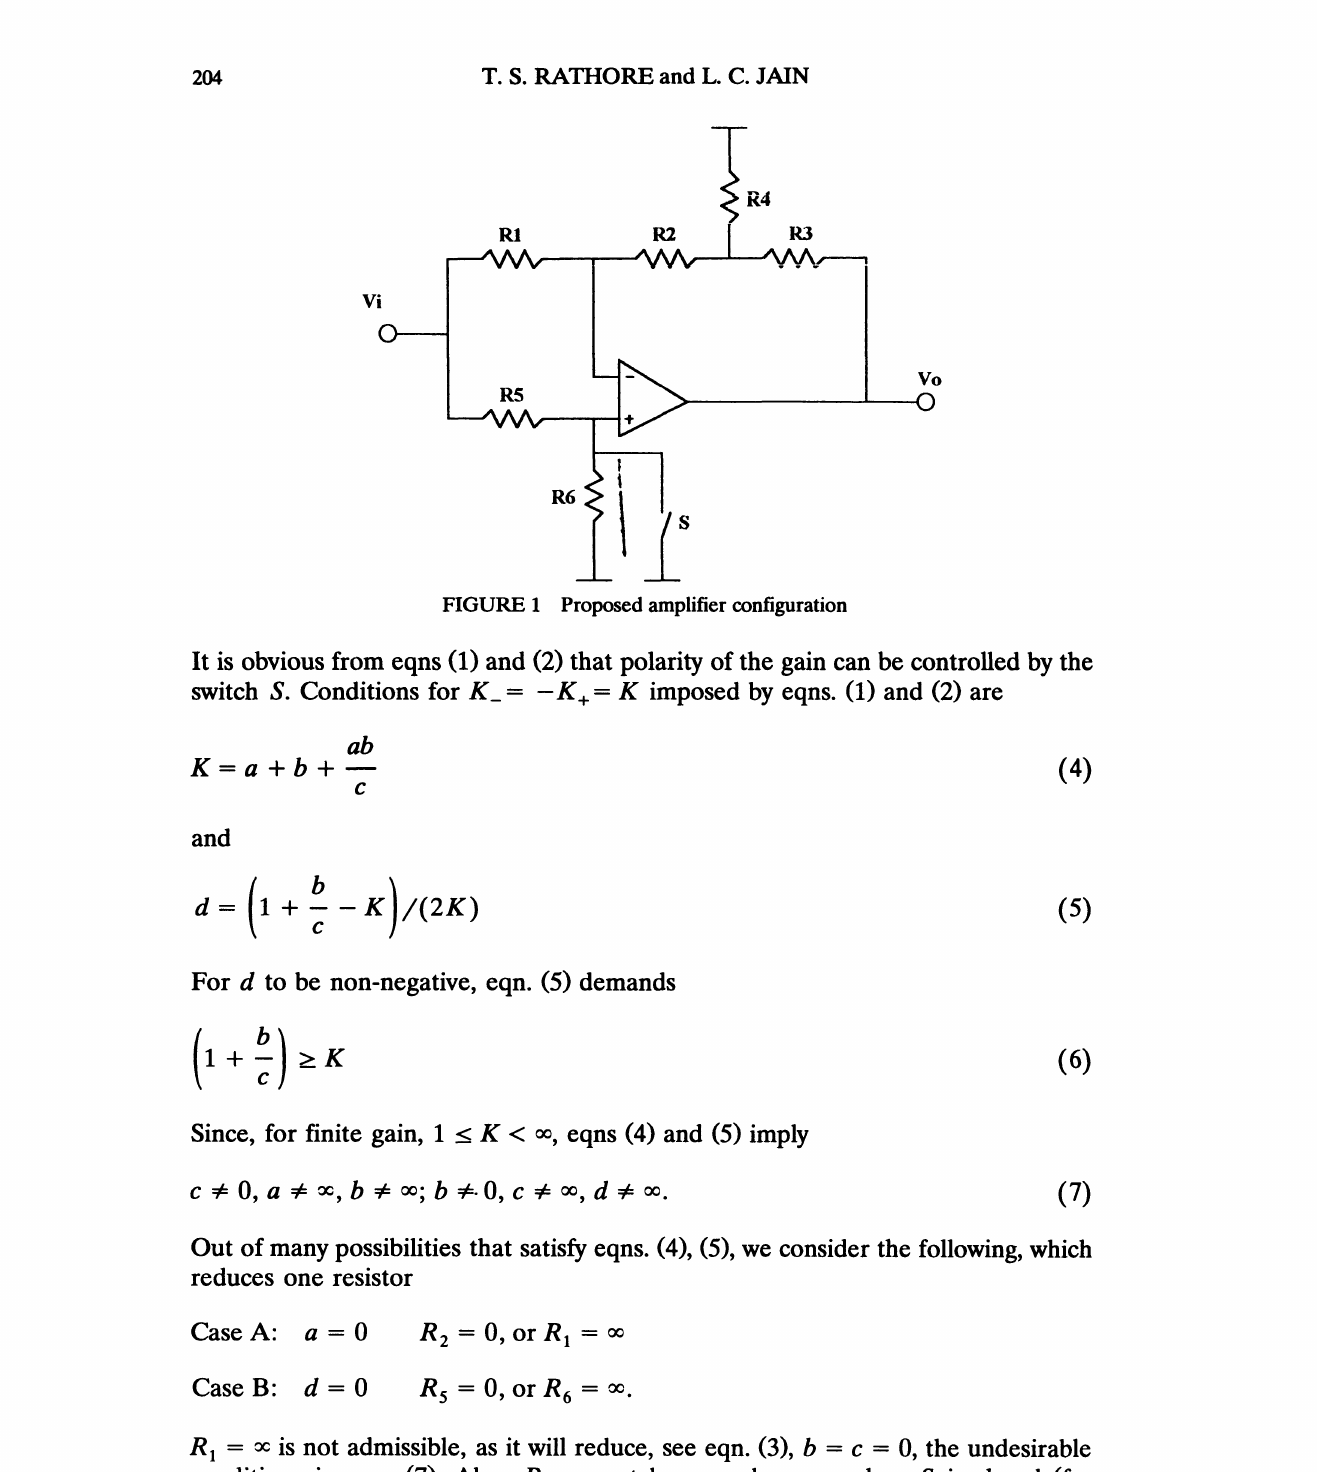
FIGURE 1 Proposed amplifier configuration